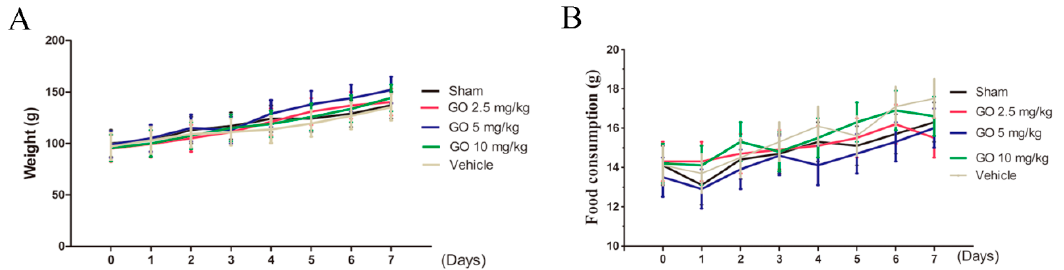
Figure 2. Body weight and food consumption. ( A ) Food consumption (g/animal/day) was observed for all GO doses. No differences were noted; ( B ) Rat weight was measured daily and these did not